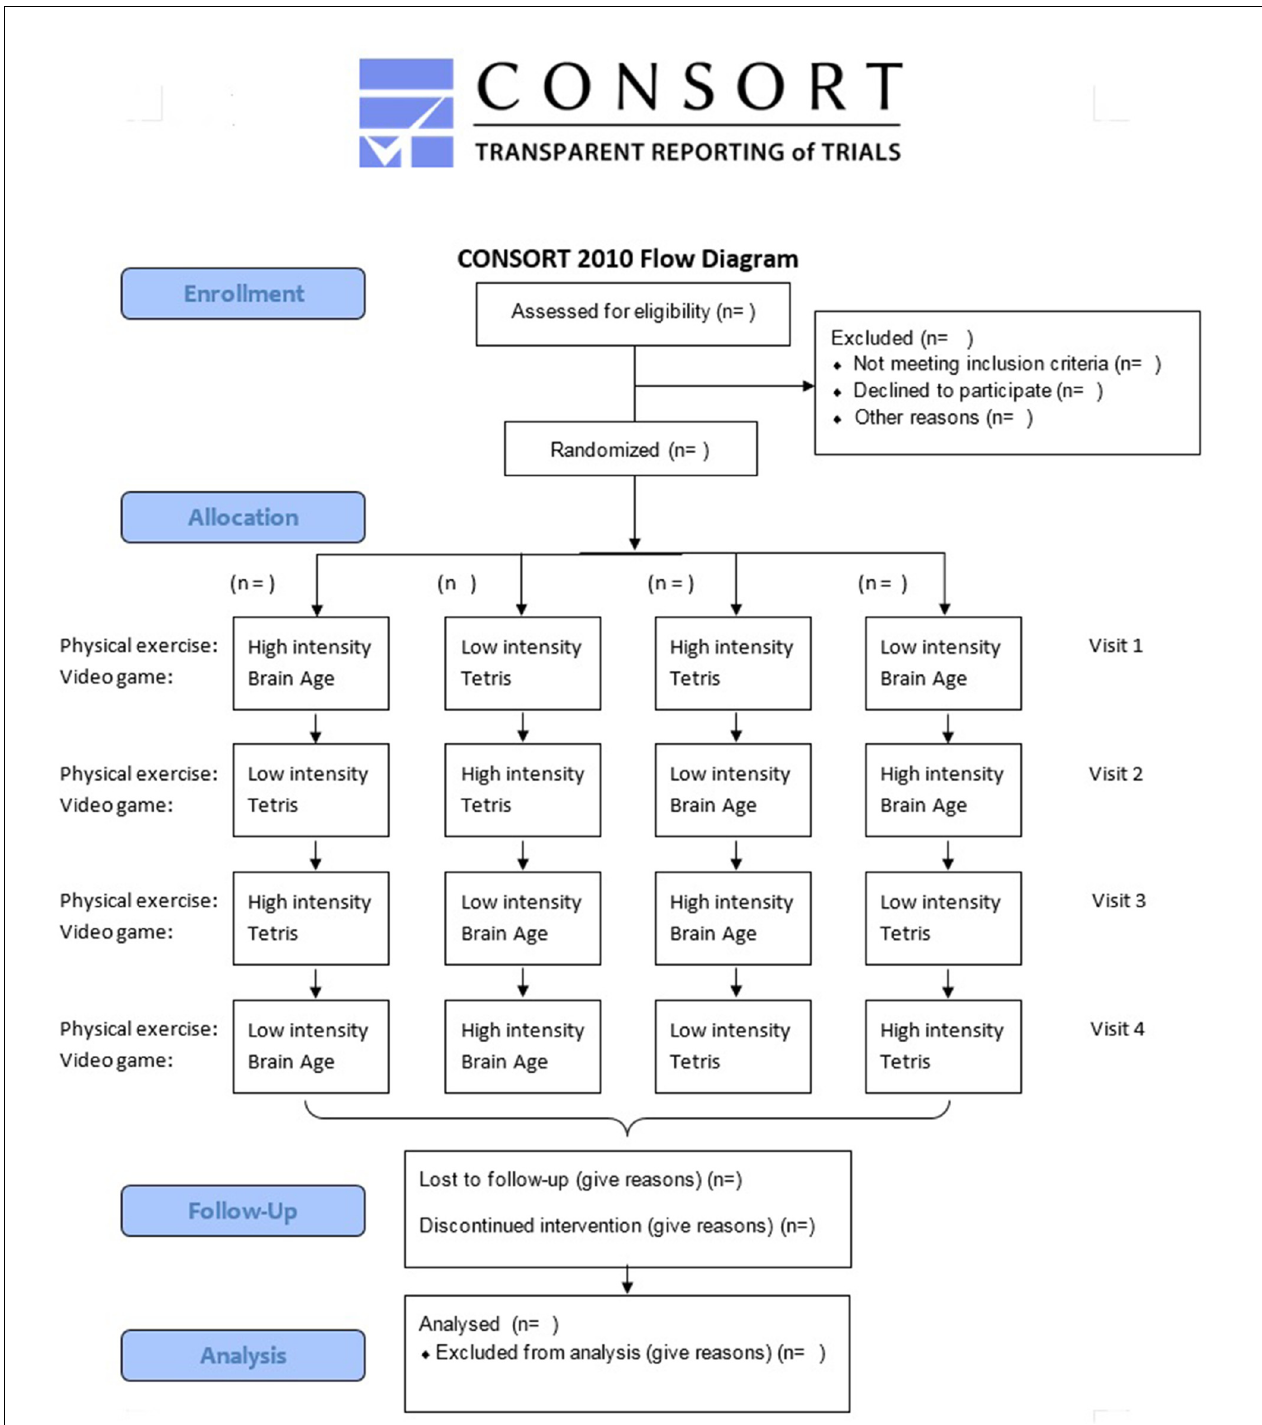
FIGURE 1 | Consolidated standards of reporting trials (CONSORT)